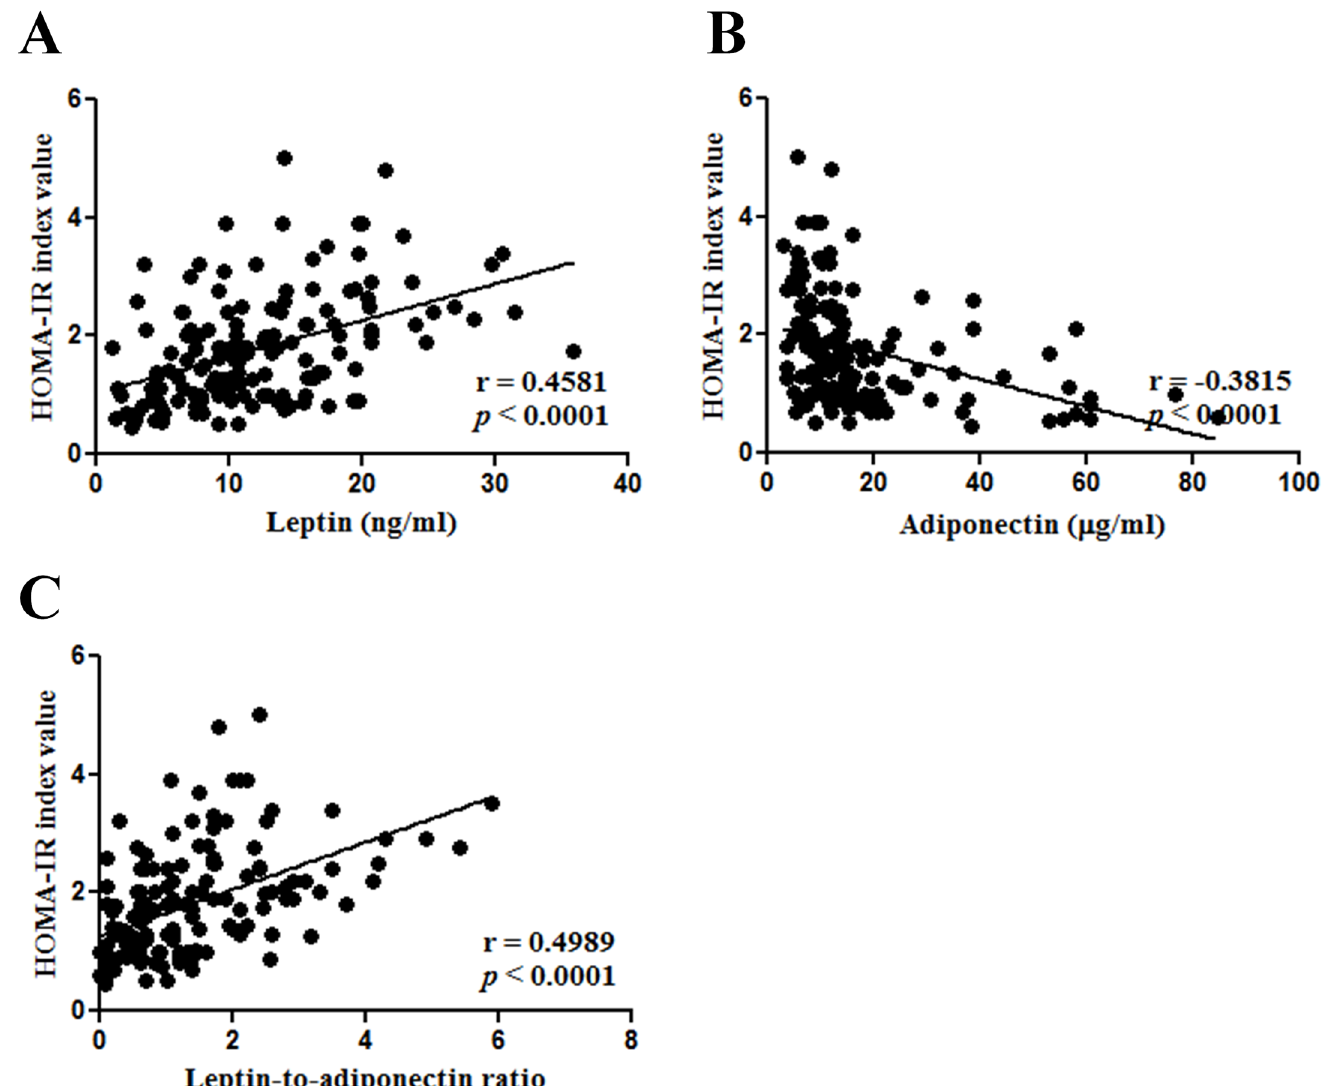
Fig 1. Associations of HOMA-IR index values with adipocyte-derived hormones. HOMA-IR index was correlatedwith leptin levels (A), adiponectin levels (B), and leptin-to-adiponectinratio (C). Statistical analysiswas conductedby Pearson’scorrelationanalysis.